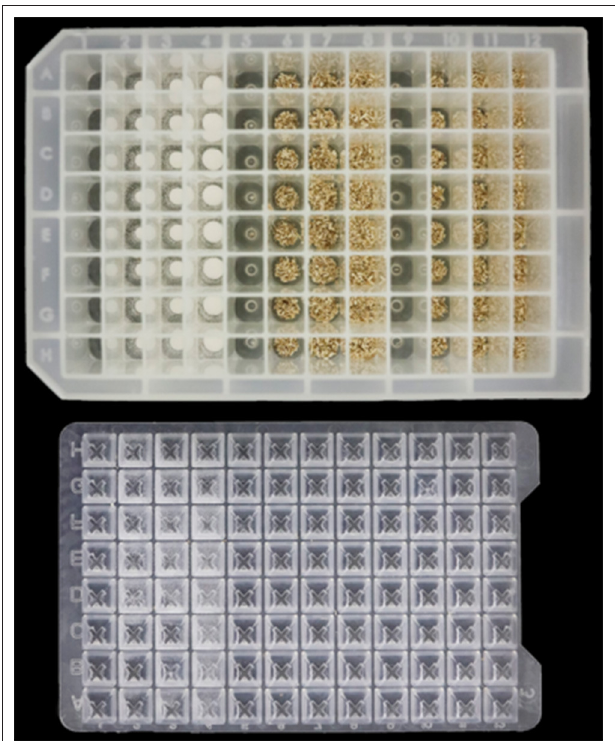
FIGURE 2 | Biomass loaded into deepwell microtiter plate for high throughput evaluation of Clostridia for consolidated biomass